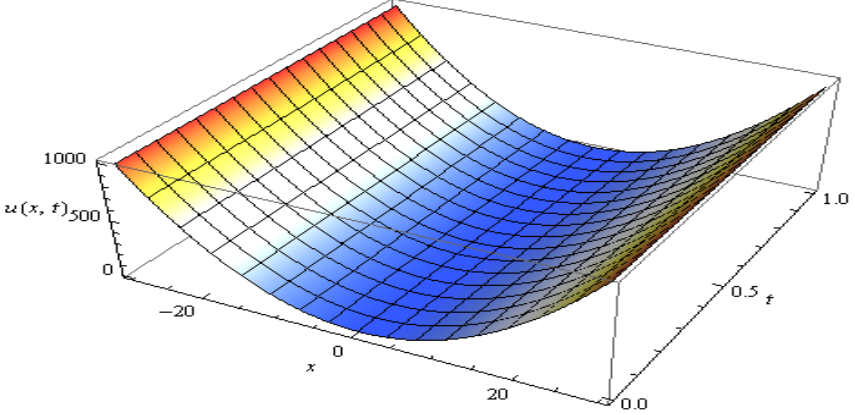
Figure 4. Super-diffusion case of incompressible second grade fluid dynamics.